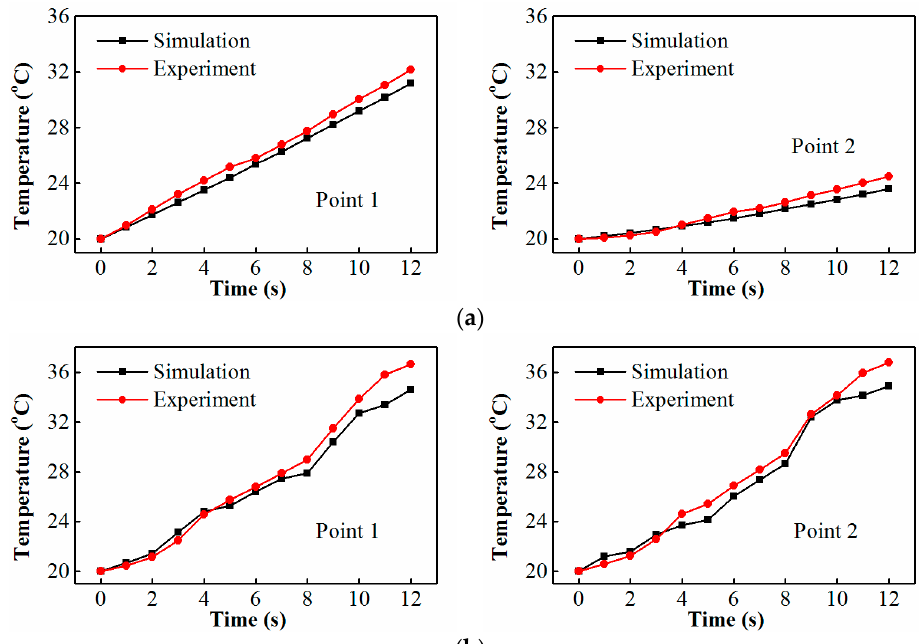
Figure 7. Simulated and experimental temperature profiles at two points of the potato subjected to 12 s heating in a 300 W microwave oven (refer to locations in Figure 5): ( a ) the turntable is composed of PE; and ( b ) turntable is composed of PE and alumina.